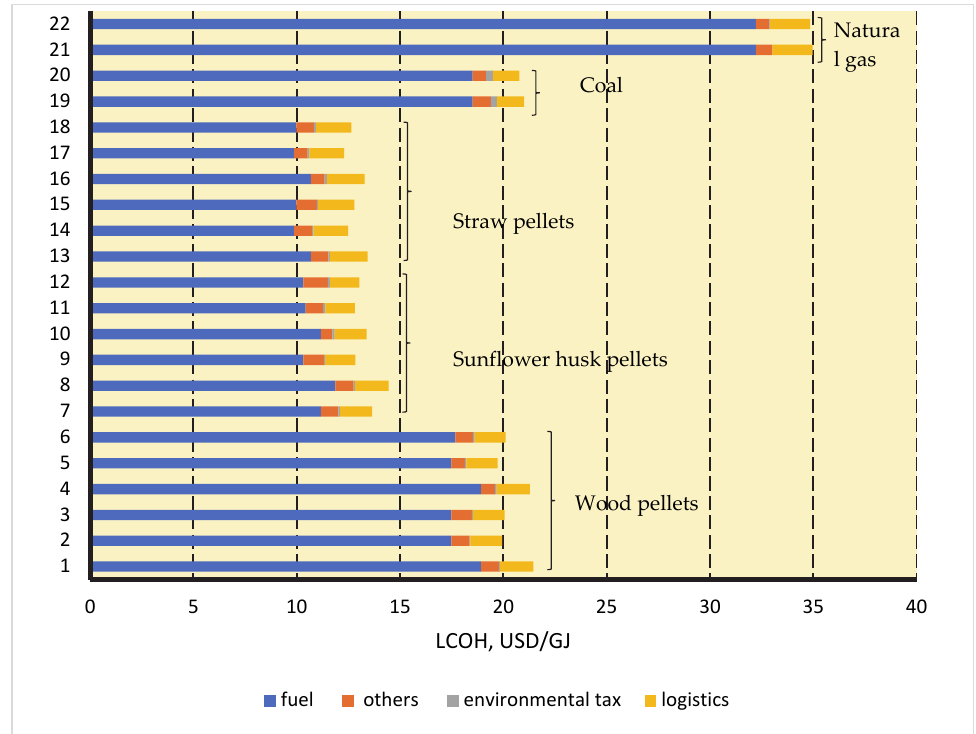
Figure 3. LCOH structure in July 2022 (the number on the x -axis corresponds to the first column in Table 4).